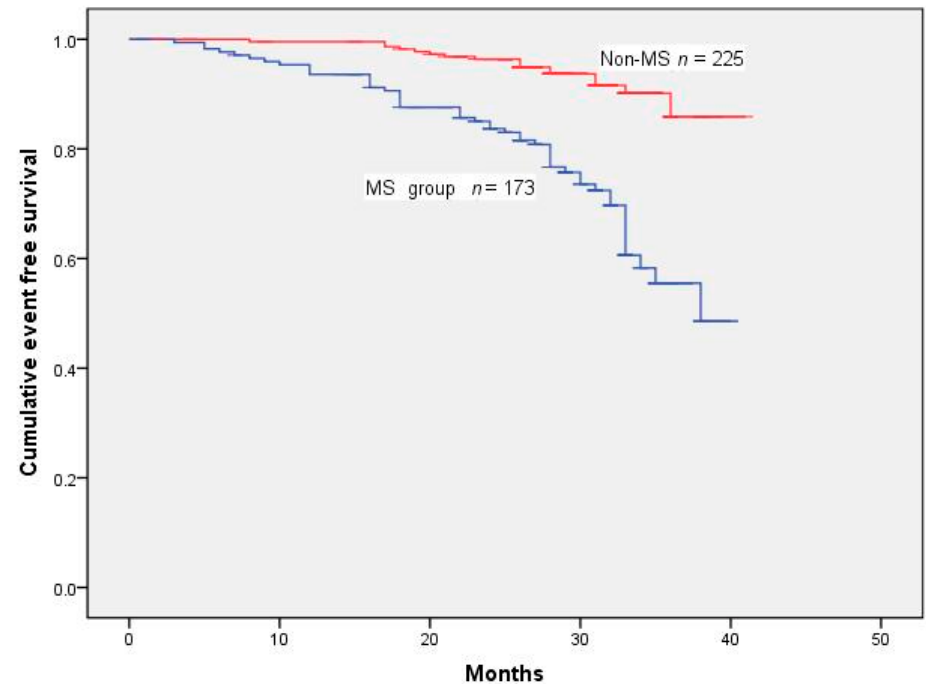
Figure 3. Cumulative survival rates censored for TVR. Survival was significantly reduced in MS patients (log-rank test p < 0.001).